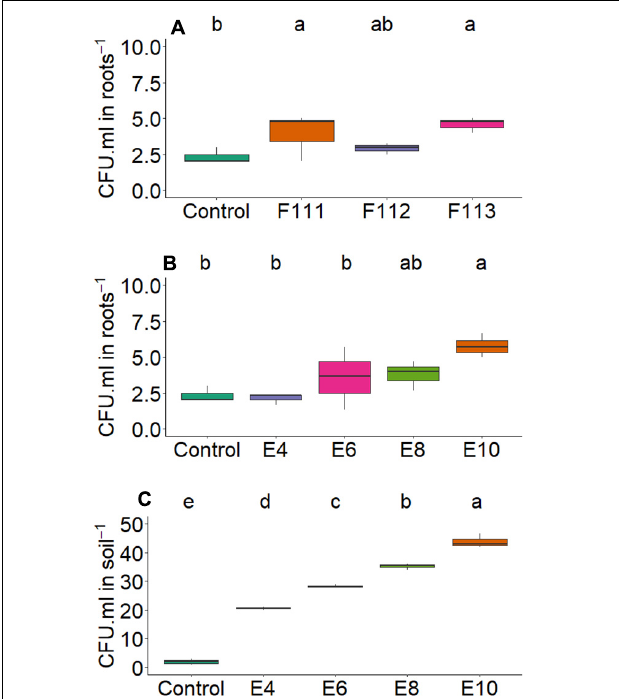
FIGURE 9 | Boxplots (median and quartiles) of CFU in root (A,B) and soil (C) inoculated with Aspergillus brasiliensis , Aspergillus sydowii , and Aspergillus sp. Different lowercase letters in a row indicate statistical difference between means (Tukey, p < 0.05). F111, Aspergillus brasiliensis ; F112, A. sydowii ; F113, Aspergillus sp.; E4, 1 × 10 4 ; E6, 1 × 10 6 ; E8, 1 × 10 8 ; E10, 1 × 10 10 conidia or CFU mL − 1 ; Ctrl, control; CFU, colony-forming